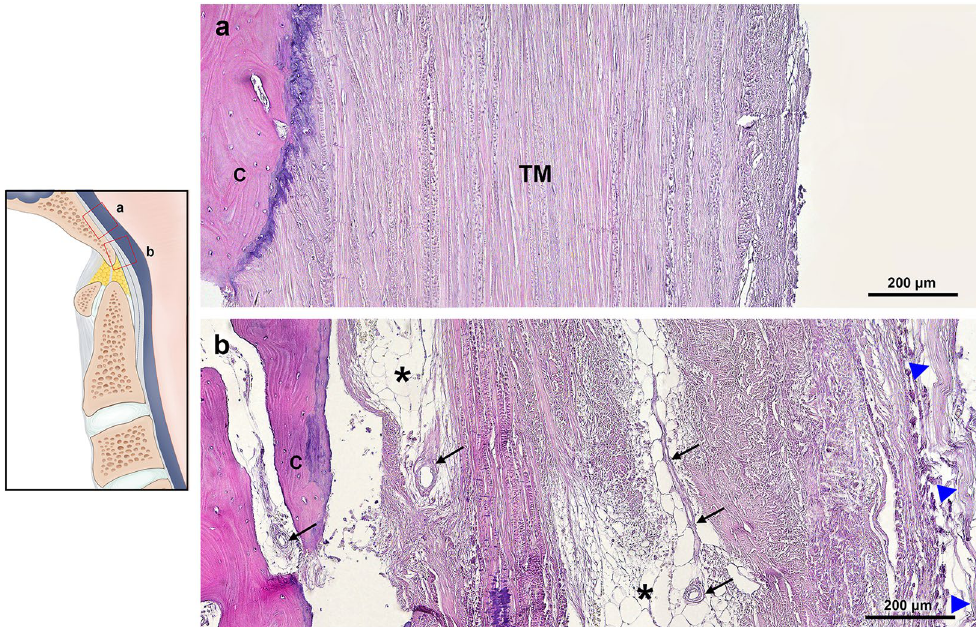
Figure 3. Attachment of tectorial membrane (TM) in the clivus. H&E stain. ( a ) The superior clivus by longitudinal section. Aligned fibers of the TM are firmly interdigitating to the bone, indistinguishable from the superior crus of the cruciate ligament and the cranial dura mater. ( b ) Multiple layers of ligamentous structures in the inferior clivus demarcated by adipose tissues (asterisks) and vessels (arrows). Arrowheads dura mater layer, c clivus, TM tectorial